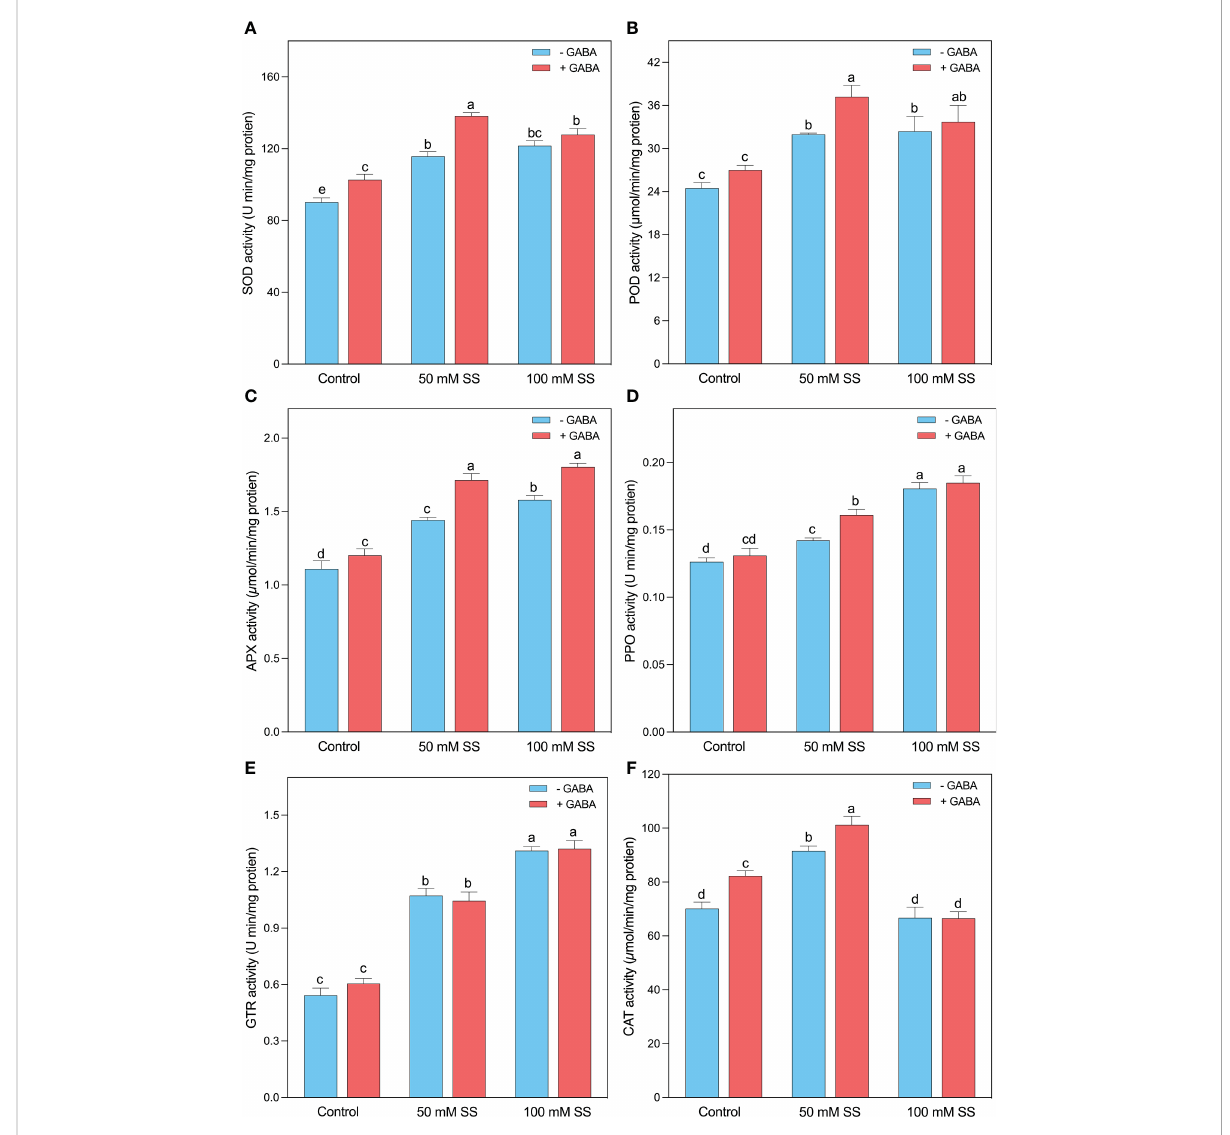
FIGURE 5 Changes in enzymatic activities of (A) SOD, (B) POD, (C) APX, (D) PPO, (E) GR, and (F) CAT of mungbean plants under saline stress (SS) and exogenous ( g -aminobutyric acid) treatments. The bars indicate the SE of the mean value, n=3. Different letters above the bars indicate signi fi cantly different values at P <0.05 following Duncan ’ s